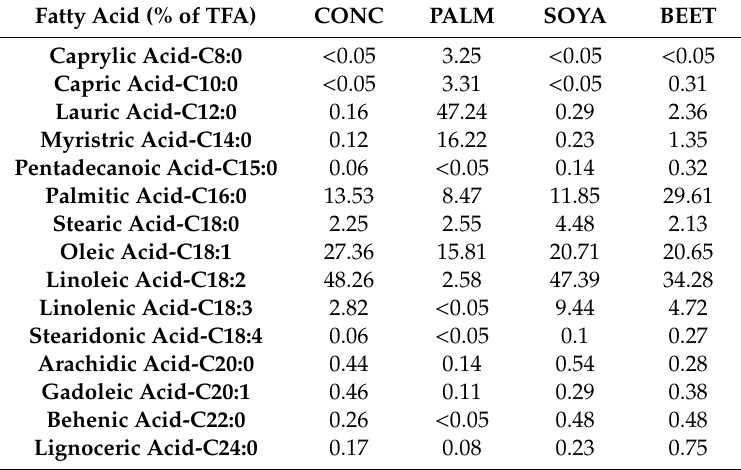
Table 5. Feed supplements mean major fatty acid triglyceride content (% of total fatty acids (TFA)). Parlour concentrate (CONC), palm kernel expeller (PALM), soya hulls (SOYA), and molassed beet pulp (BEET). Fatty Acid (% of